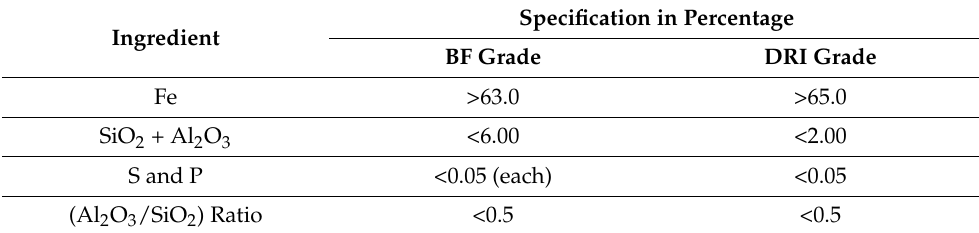
Specification in